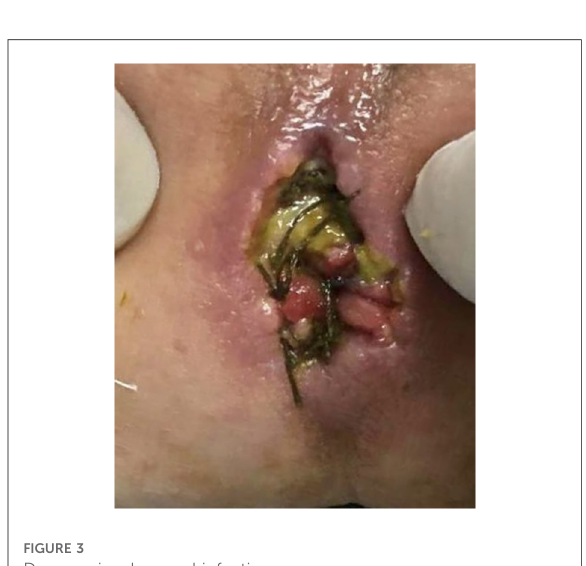
FIGURE 3 Deep perineal wound